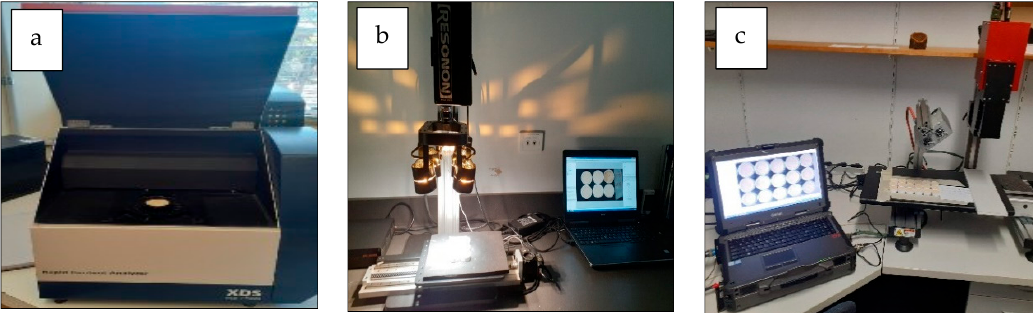
Figure 2. The near infrared spectrometer (NIRS, 400–2500 nm) ( a ), visible to near infrared hyperspectral imaging system (VNIR HSI, 400–1000 nm) ( b ) and shortwave infrared HSI system (SWIR HSI, 1000–2500 nm) ( c ) used in this study.